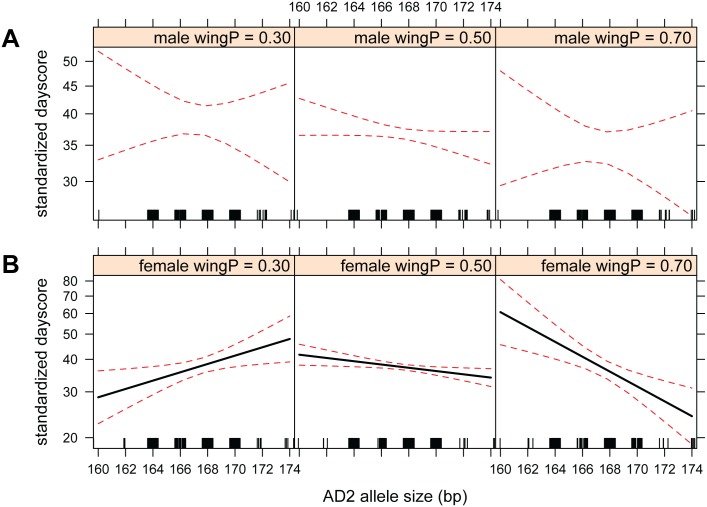
Sex-effect of AD2 allele size x wing pointedness among all populations.Effect of ADCYAP1 allele size (x-axis) x wing pointedness (Wing P measured as Holynski Index: left = 0.30, center = 0.50, right 0.70) on standardize dayscore (y-axis); lower Holynski indices correspond with more rounded wings (left panels) and greater indices correspond to more pointed wings (right panels). A) males: p = 0.552 after FDR (N = 389) and B) females: p = 0.028 after FDR (N = 306). Set 5 Shown.